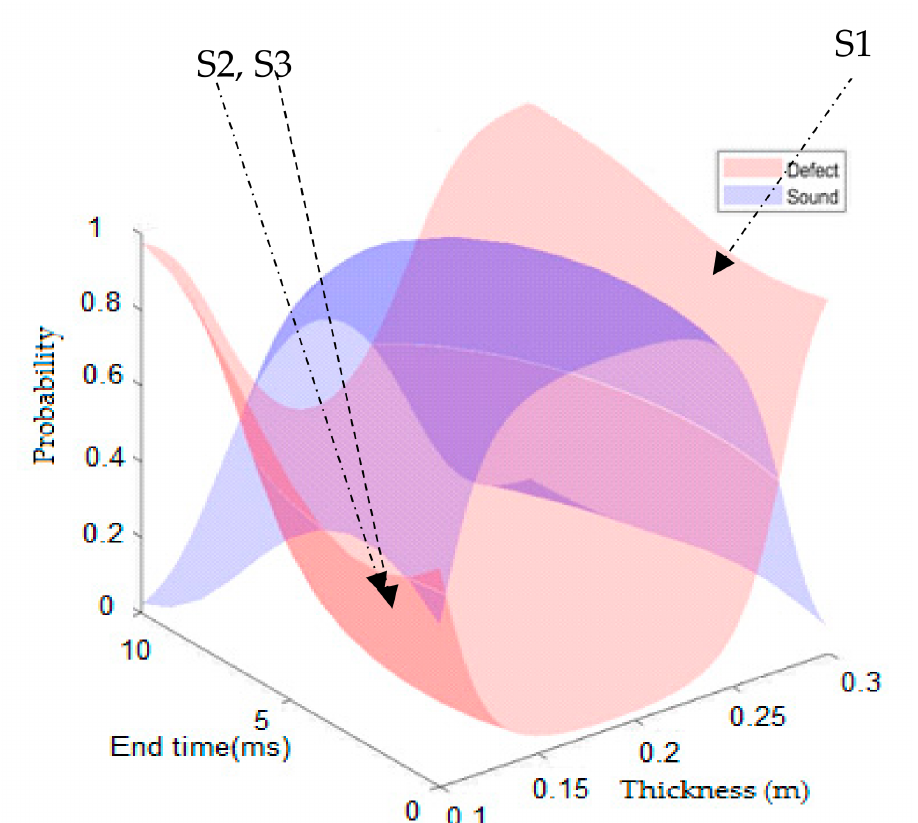
Figure 12. Probability surface to find the relationship between the feature (end time) of IE signals in the time domain and the estimated thickness using frequency domain (slab